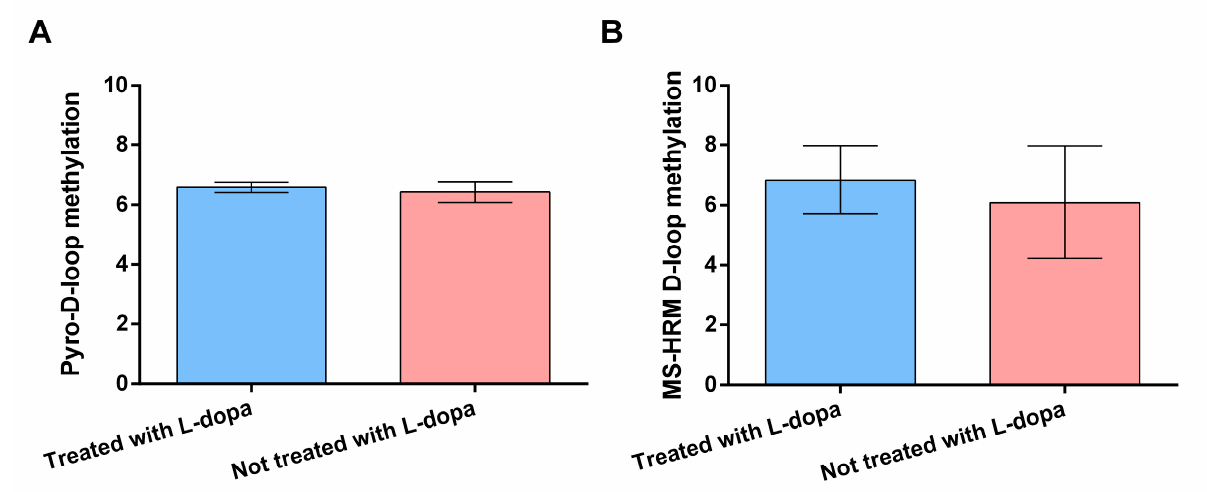
Figure 2. Pyrosequencing ( A ) and MS-HRM ( B ) D-loop region methylation levels in PD patients treated with L-dopa ( n = 22) and PD patients not treated with L-dopa ( n = 8). Data are expressed as means ± SEM. Statistical analysis was performed by means of ANCOVA, including age at sampling and sex as covariates.